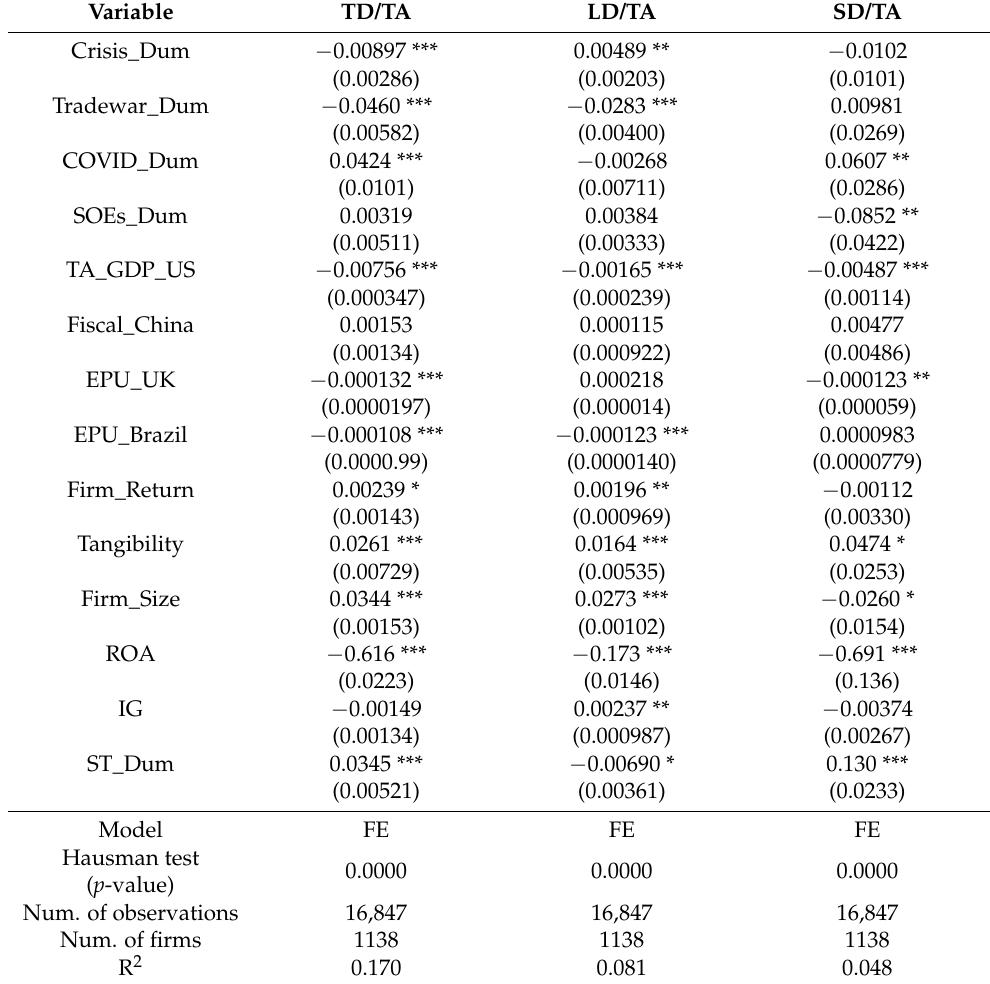
Table 4. The impacts of the Great Recession, Trade War, and COVID-19 on capital structure.